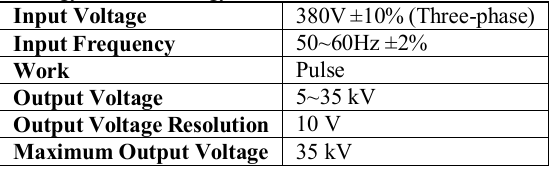
Table 1 . The parameters of the GYCOM anode power supply for #1 gyrotron and #4 gyrotron.